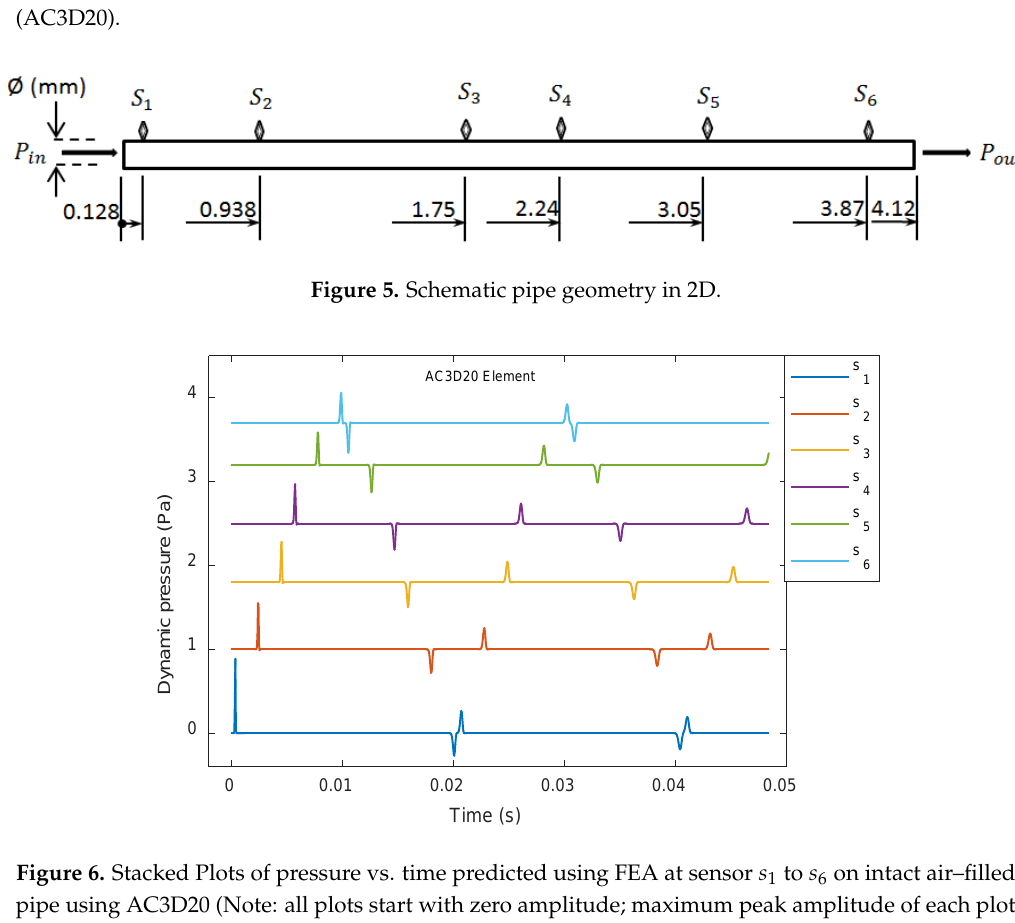
Figure 6 . Stacked Plots of pressure vs. time predicted using FEA at sensor s 1 to s 6 on intact air–filled pipe using AC3D20 (Note: all plots start with zero amplitude; maximum peak amplitude of each plot is less than 1.0 Pa) .